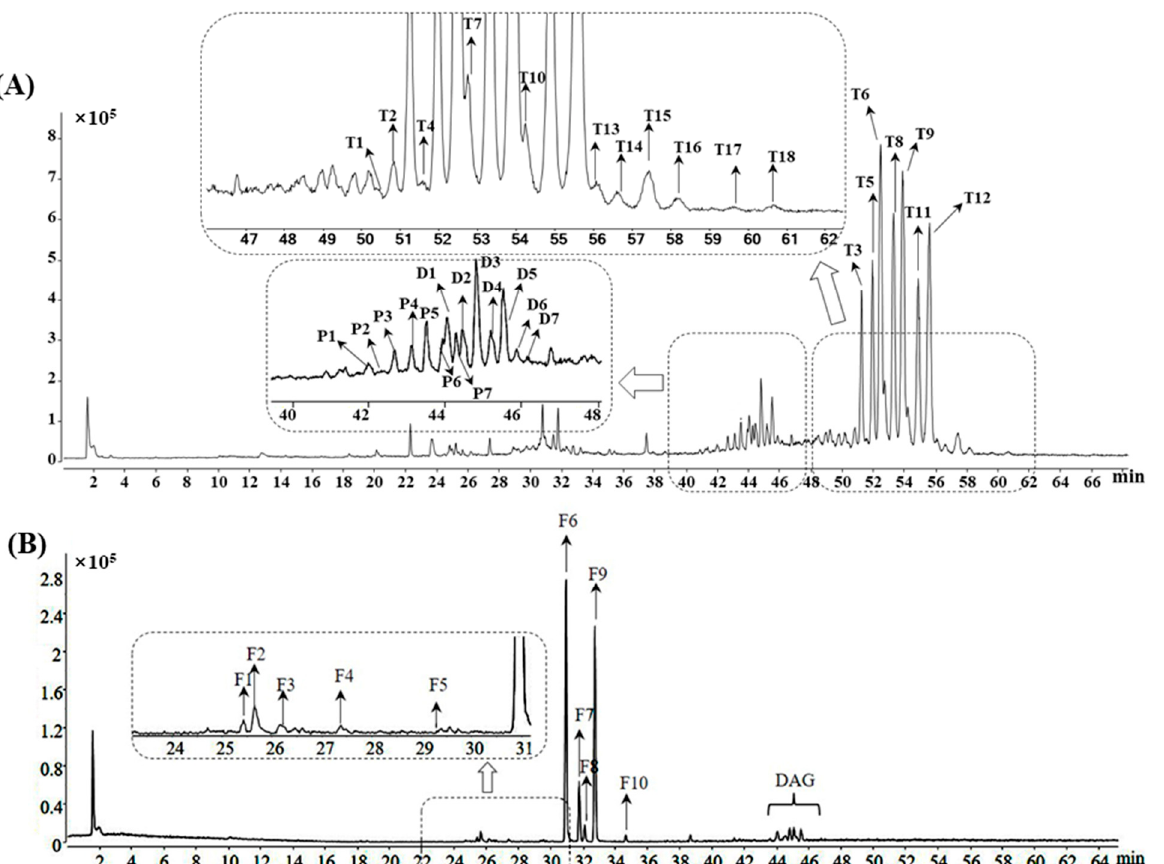
Figure 1. Total ion chromatogram of coix seed sample under positive ( A ) and negative ( B ) detection mode by UHPLC-QTOF-MS.